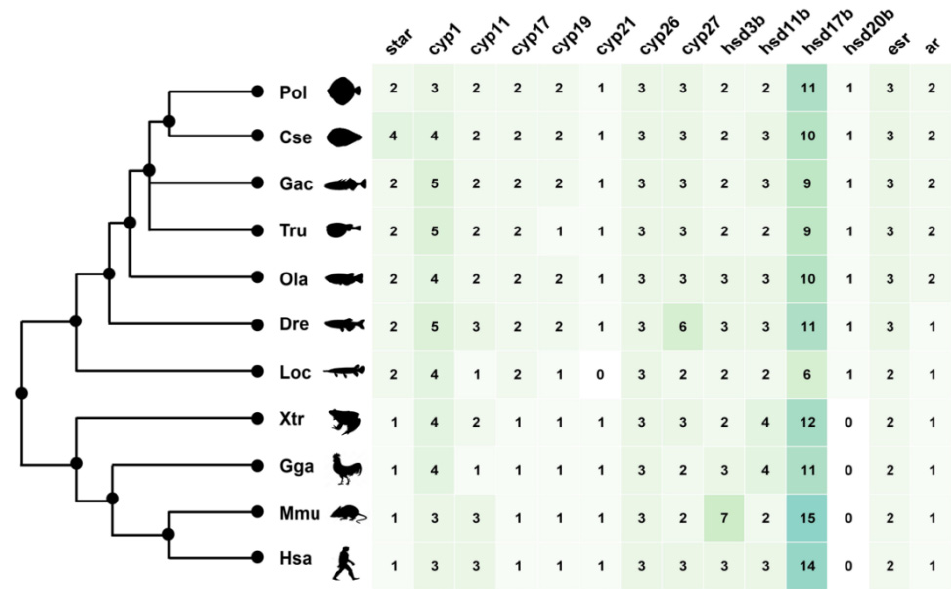
Figure 1. Copy number of steroidogenic genes in selected vertebrate genomes presented as a heatmap along with their phylogeny. The color background represents the gene number. Abbreviations as follows: Pol: Paralichthys olivaceus ; Cse: Cynoglossus semilaevis ; Gac: Gasterosteus aculeatus ; Tru: Takifugu rubripes ; Ola: Oryzias latipes ; Dre: Danio rerio ; Loc: Lepisosteus oculatus ; Xtr: Xenopus tropicalis ; Gga: Gallus gallus ; Mmu: Mus musculus ; Hsa: Homo sapiens . Specifically, 16 and 17 cyp genes were obtained in the P. olivaceus and C. semilaevis genomes, respectively. There were comparable numbers of cyp1 , cyp11 , cyp21 , cyp26 and cyp27 genes between tetrapods and teleosts, whereas two cyp17 s and two cyp19 s were identified in teleosts but only one copy was found in tetrapods, indicating their putative TSGD origin in teleost lineages (Figure 1 and Table S1). Five conserved motifs (motif 1–5)